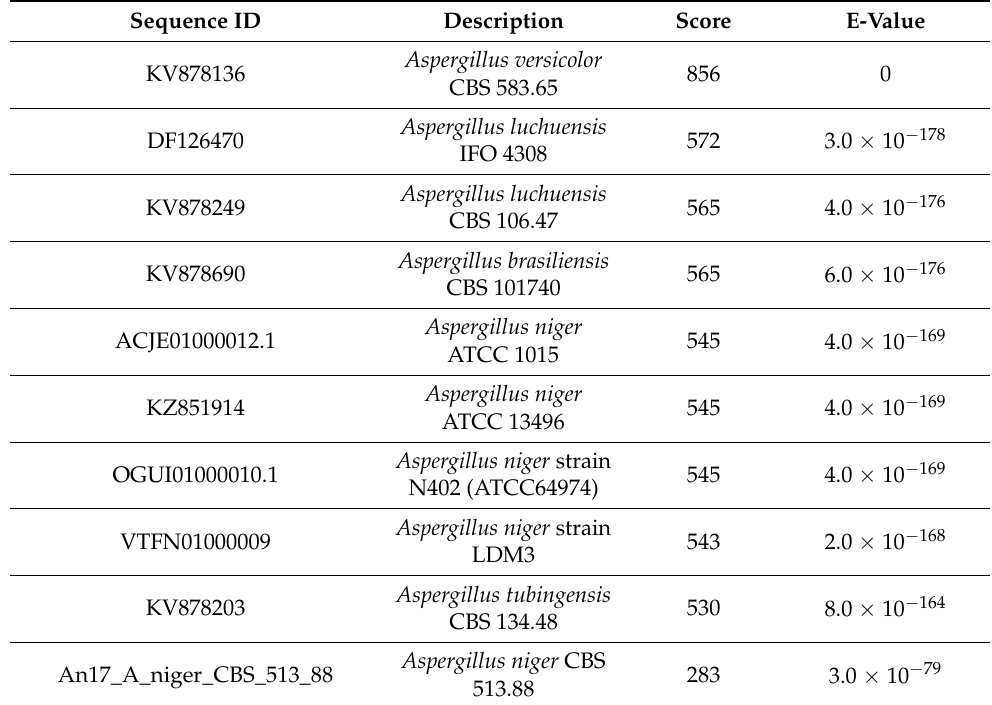
Table 1. AN11127/Sec12 homologues that were not automatically identified by